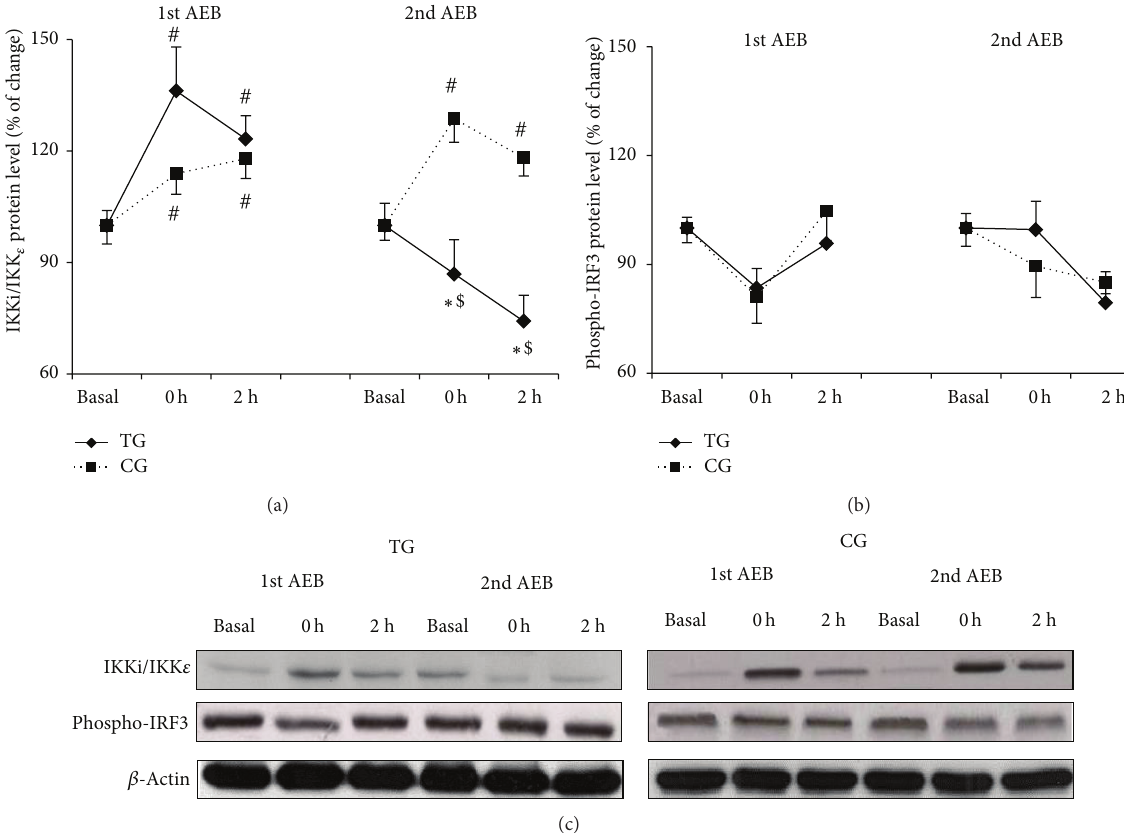
Figure 5: Training attenuates IKKi/IKK 𝜀 activation induced by acute eccentric exercise. IRF3 phosphorylation is not altered as result of acute eccentric exercise nor training. Total IKKi/IKK 𝜀 (a) and phospho-IRF3 (b) protein levels after the first and the second acute eccentric bout (AEB) for training group (TG, solid line) and control group (CG, dotted line) and representative Western blots (c). Mean ± SEM. ∗ 𝑃 < 0.05 versus CG; # 𝑃 < 0.05 versus basal value, same group; $ 𝑃 < 0.05 versus 1st acute eccentric bout, same